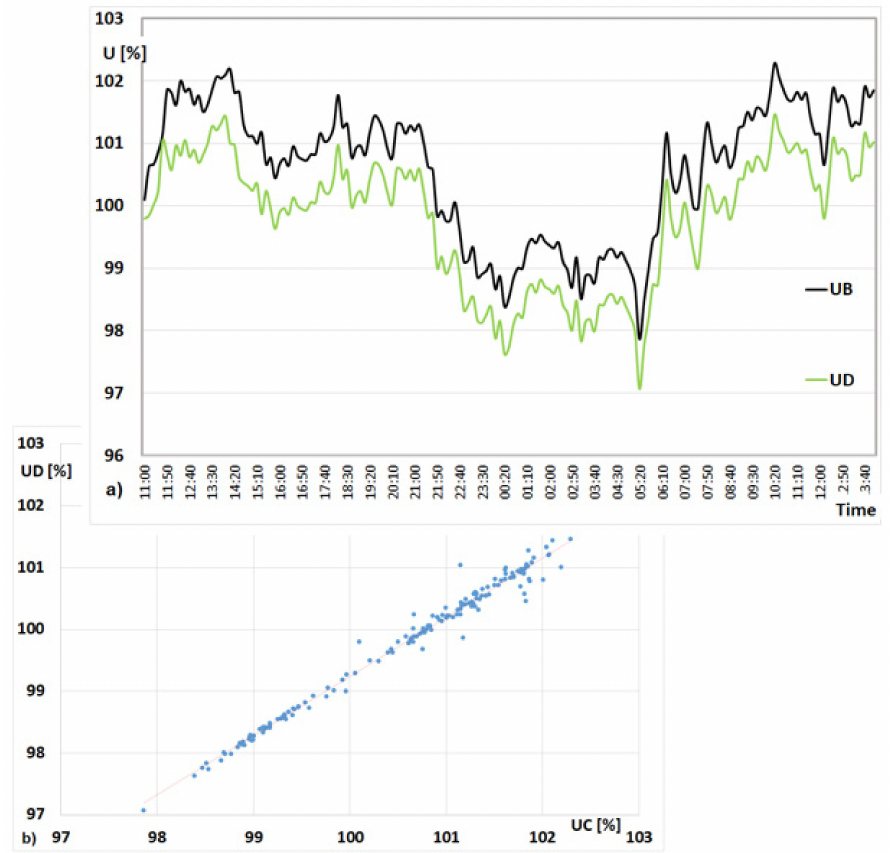
Figure 24. RMS voltage waveform ( a ) and correlation ( b ) between voltage changes recorded at points B and